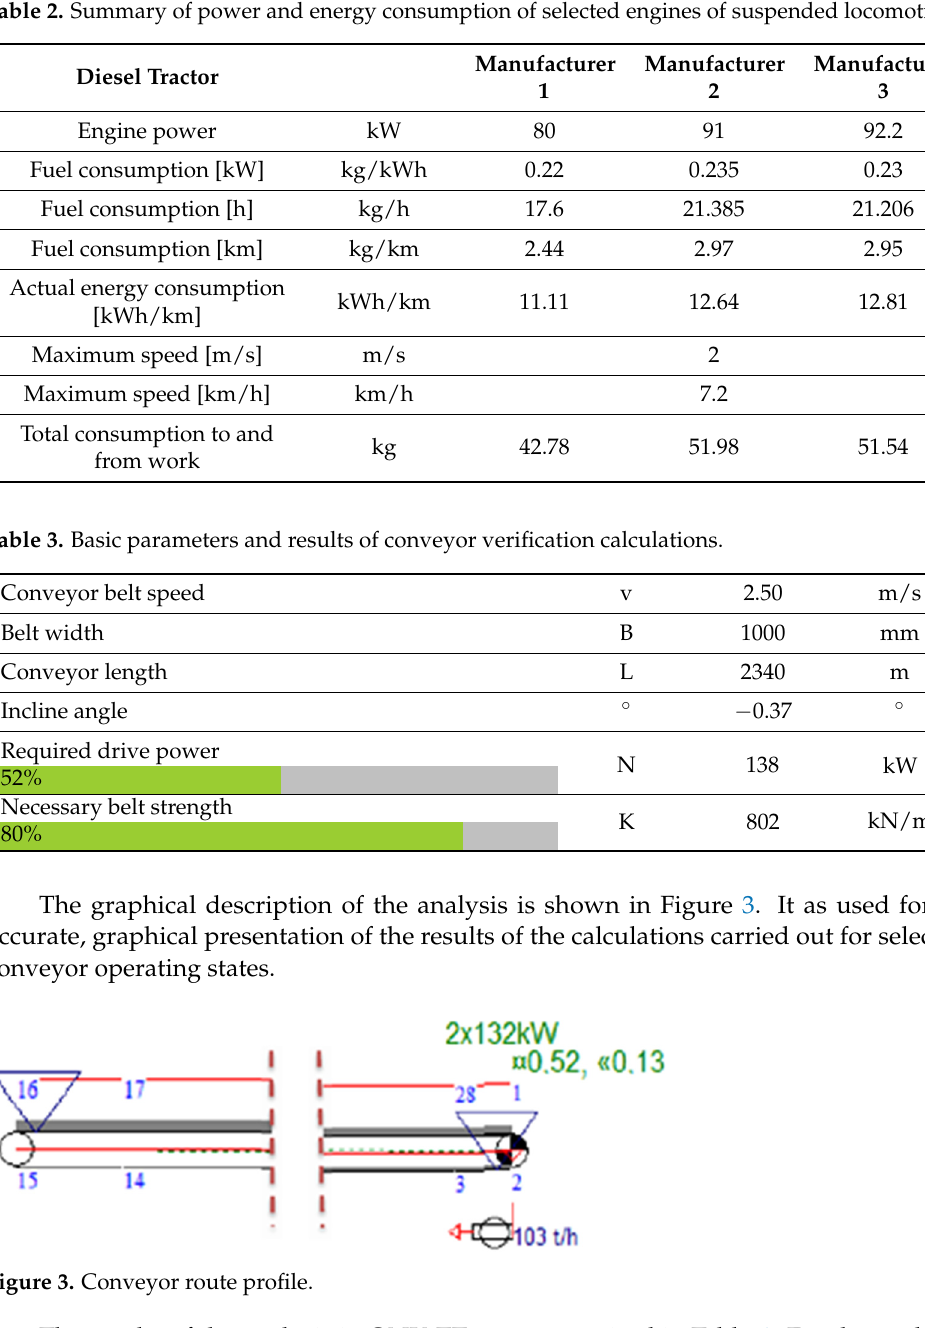
Table 2. Summary of power and energy consumption of selected engines of suspended locomotives.